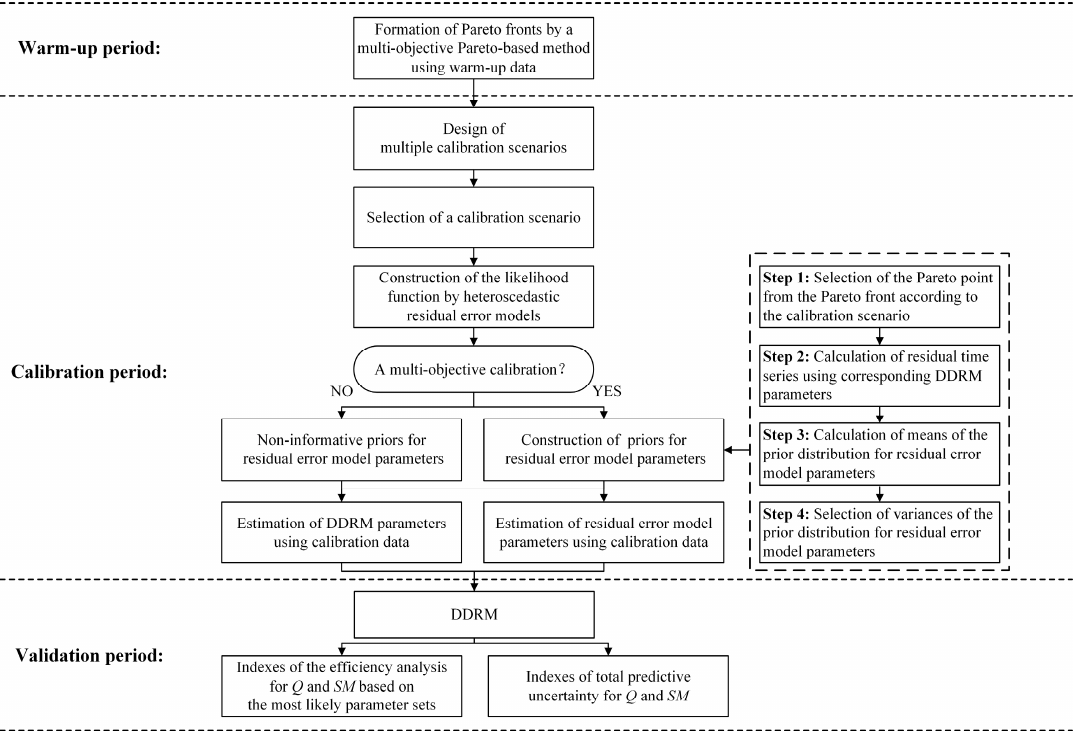
Figure 4. Graphical summary of the Bayesian hierarchical calibration framework in this study. DDRM: DEM-based Distributed Rainfall-Runoff Model.